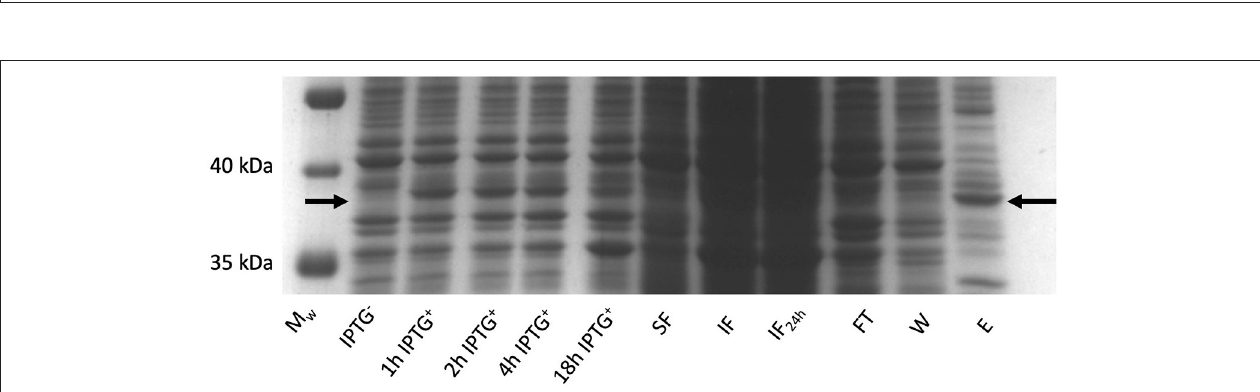
FIGURE 3 | RrADH expression in E. coli LEMO21 (DE3) strain in 1 liter (bioreactor) of TB medium at 28 ◦ C analyzed by SDS-PAGE. M w – protein ladder; IPTG − - before induction with IPTG; 1h IPTG + - 1h after induction; 2h IPTG + - 2h after induction; 4h IPTG + - 4h after induction; 18h IPTG + - 18h after induction; SF – soluble fraction; IF – insoluble fraction; IF24 – insoluble fraction incubated in sonication buffer with addition of 2 % SDS (w/v) for 24h; FT – IMAC flow-through; W – IMAC wash; E – IMAC elution fraction.